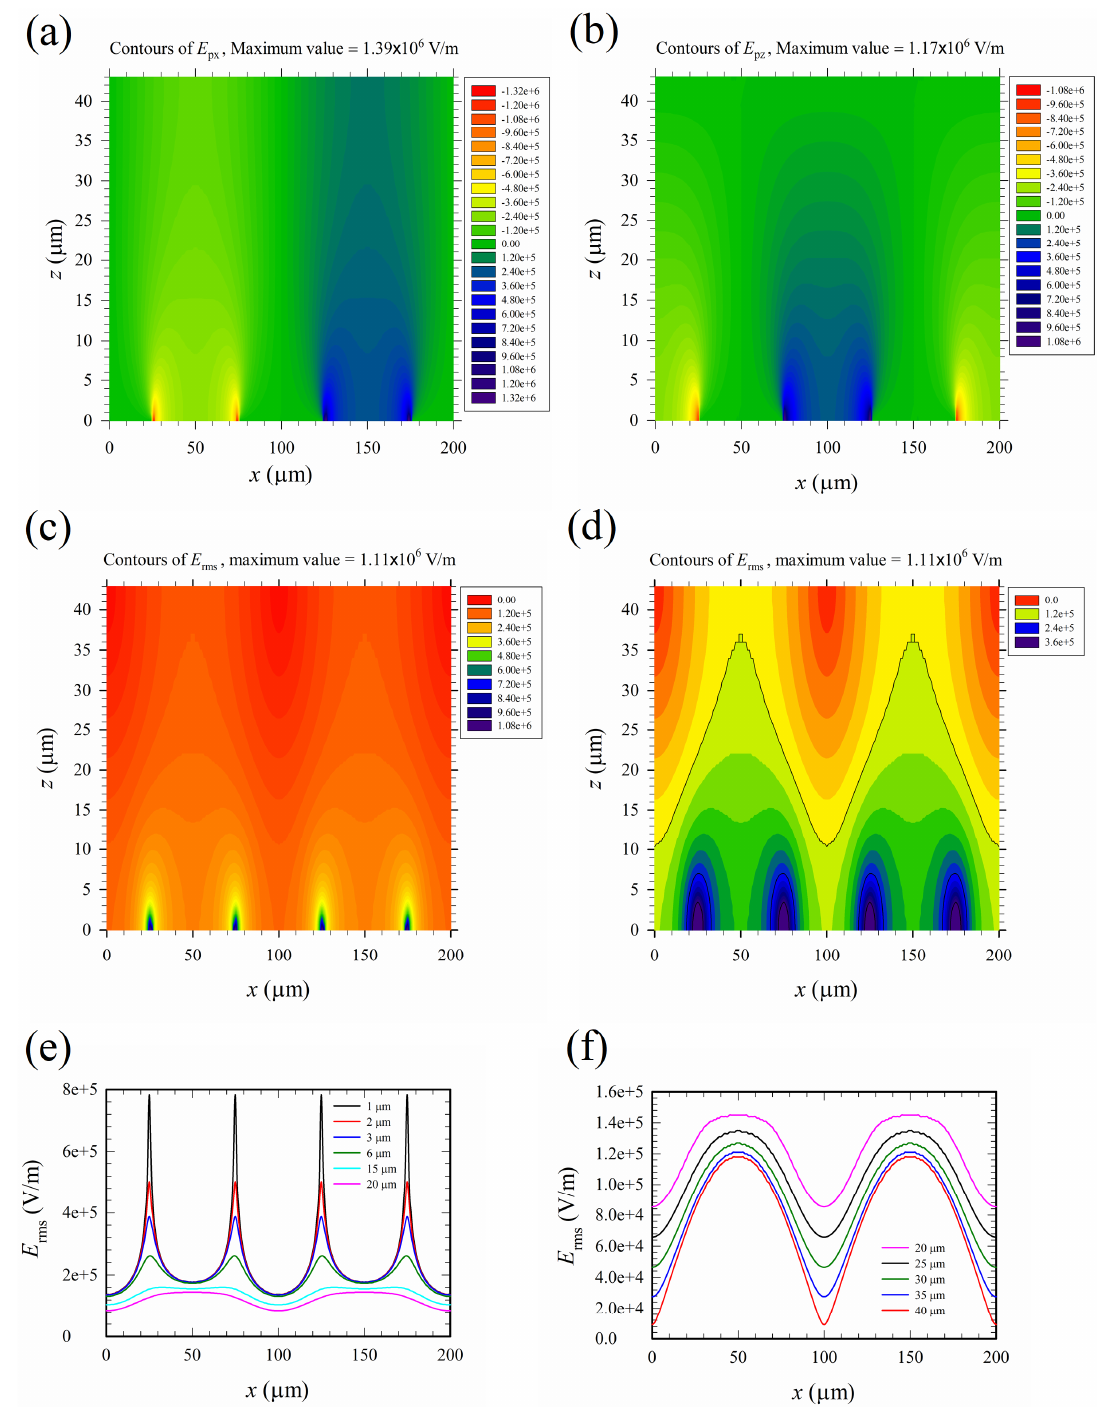
Figure 6. ( a ) Contours of the x -component electric field phasor, E px . ( b ) Contours of the z -component electric field phasor, E pz . ( c ) Contours of the root mean square of the electric field, E rms (full range). ( d ) Contours of E rms (partial range) for a clear picture of values around 1.2 × 10 5 V / m, the irreversible threshold value for electroporation, E th2 . The black curves starting from above in ( d ) are the major contours of values 1.2 × 10 5 (the black M-shape curve), 2.4 × 10 5 , and 3.6 × 10 5 V / m (four half ellipses enclosing the electrode edges), respectively. There are five minor contours between any two major contours, with a 2 × 10 4 V / m di ff erence in value between any two minor contours, for example, the values of the minor contours above the M-shape curve are 1.0 × 10 5 , 0.8 × 10 5 , 0.6 × 10 5 , 0.4 × 10 5 and 0.2 × 10 5 , respectively, starting from below (from yellow to red colors). ( e ) and ( f ) Variations of E rms with x at di ff erent heights ( z ). The applied voltage is 20 V pp . The two-dimensional “walls” of high intensity electric field generated by the edges of planar electrodes were more effective at intercepting translating cells in comparison with the spike-like high intensity field regions (like a “fence” instead of a “wall”) generated by three-dimensional electrodes in the literature, for example, Ref. [16]. There were four such “walls” in each cycle of